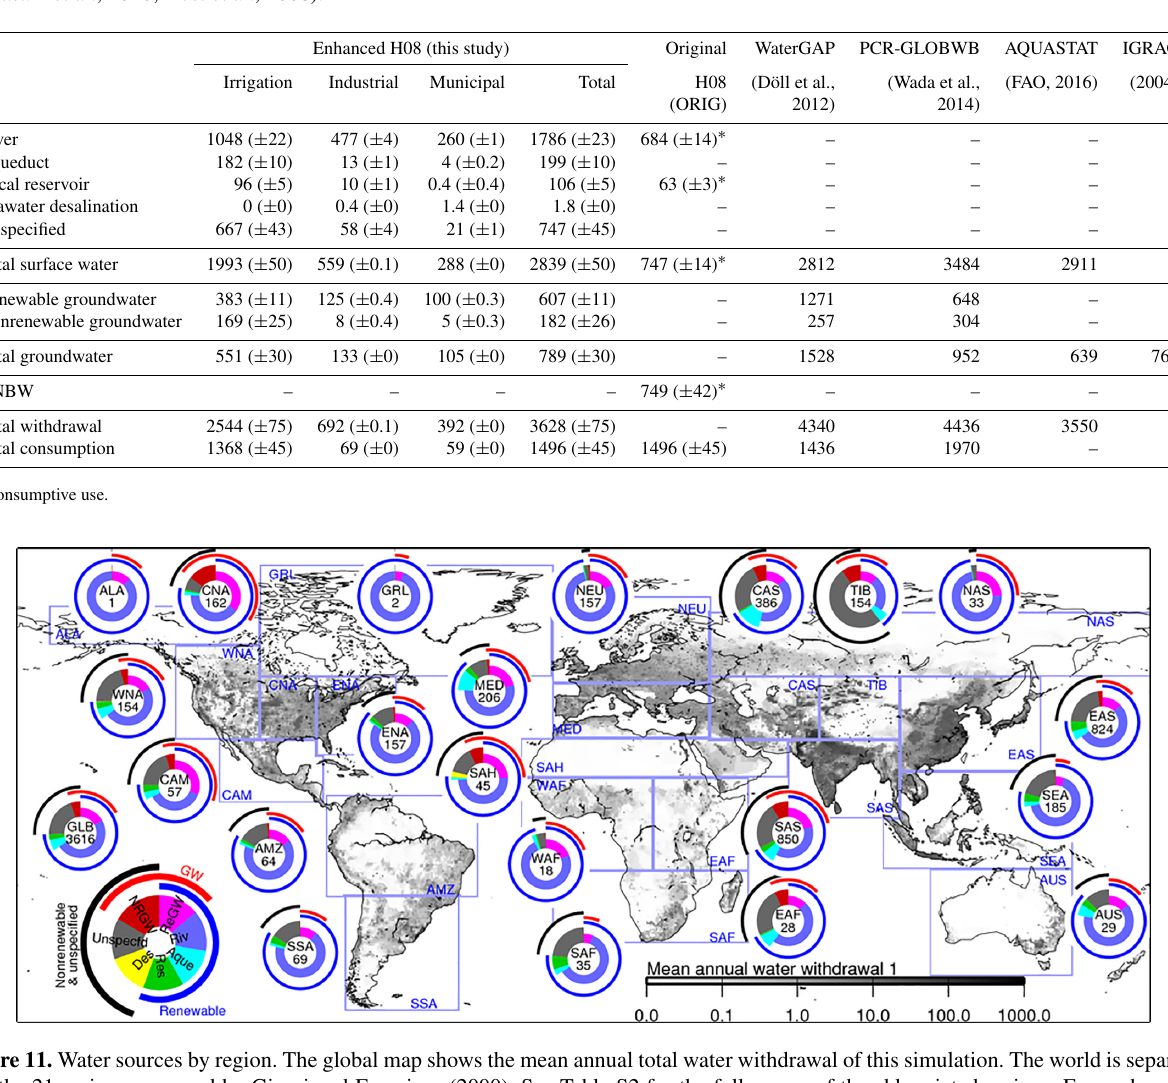
Table 5. The mean annual volume of water abstraction by sources and sectors. All terms are withdrawal-based, except the results of the original H08 model (the ORIG simulation; see Sect. S4), which is consumption-based. NNBW is nonlocal and nonrenewable blue water (Hanasaki et al., 2010; Rost et al., 2008).